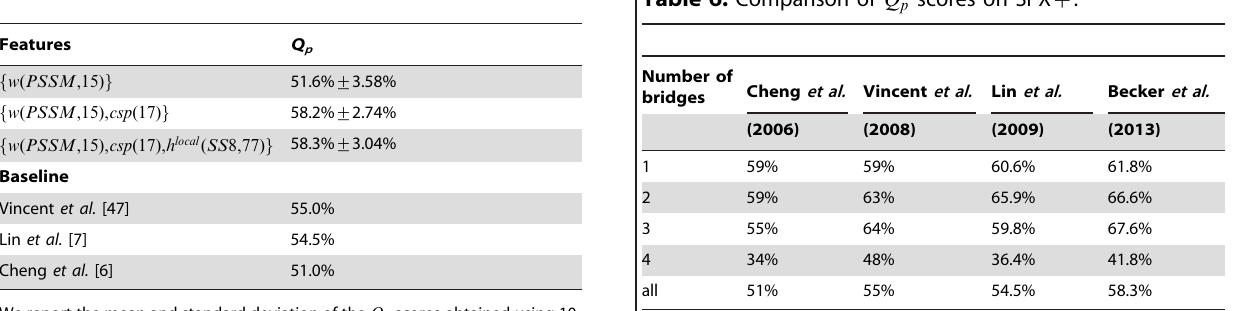
Table 6. Comparison of Q p scores on SPX z